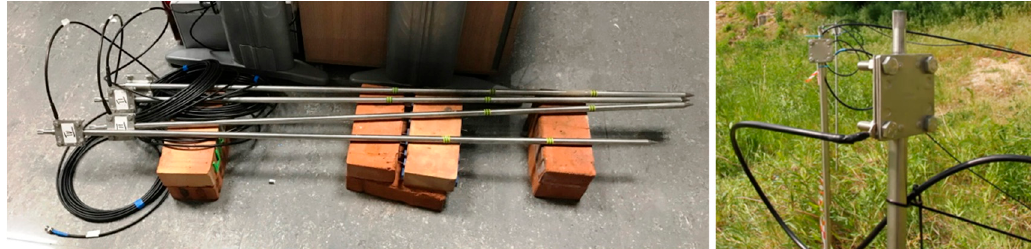
Figure 7. Electrodes in TERT device.